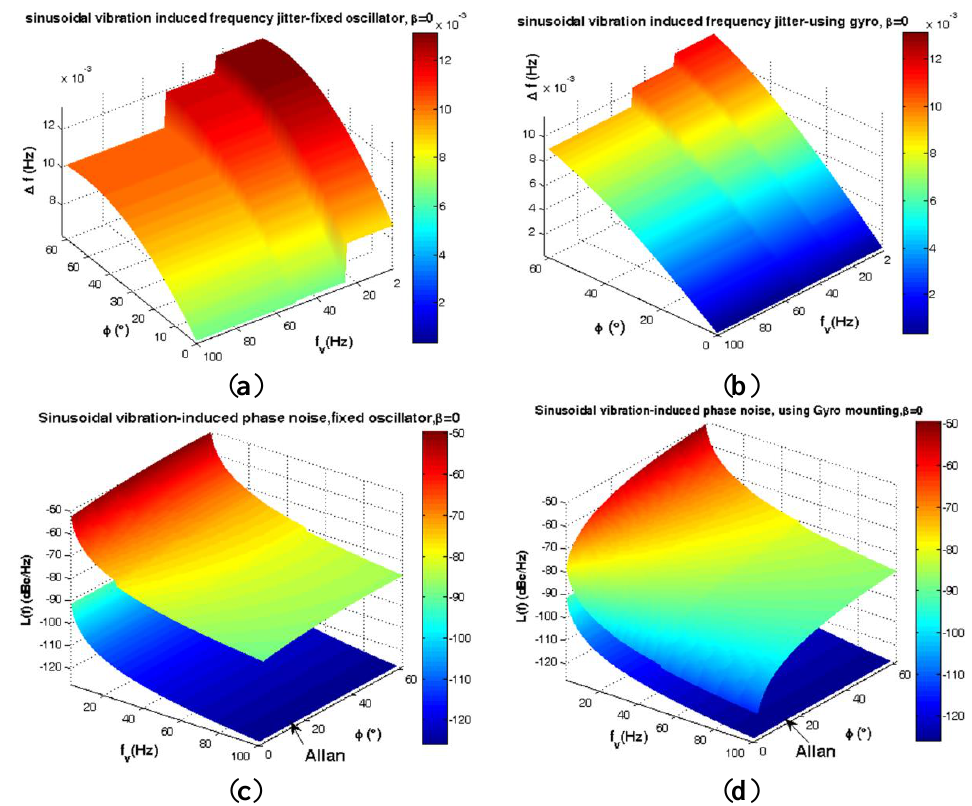
Figure 16. Sinusoidal vibrations-induced short term instability for critical state β = 0. ( a ) Frequency jitter of fixed oscillator; ( b ) Frequency jitter of gyroscopic mounting; ( c ) Phase noise of fixed oscillator; ( d ) Phase noise of gyroscopic